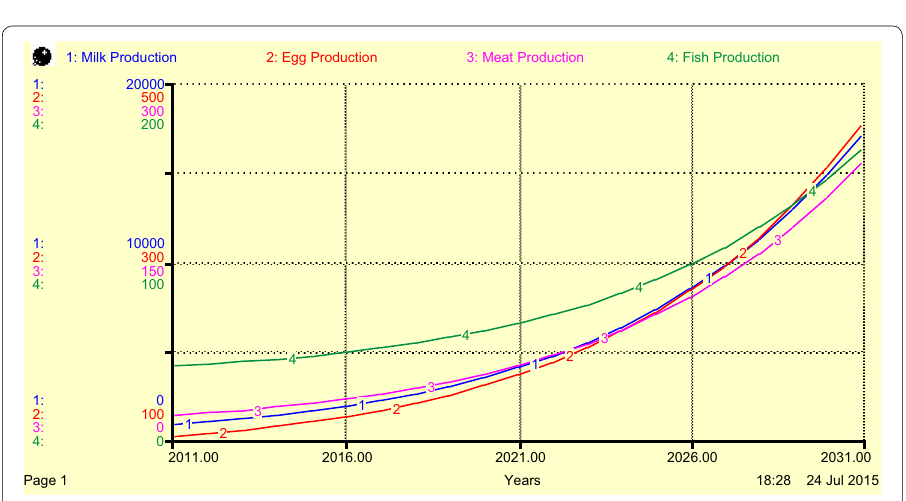
Fig. 20 Perceived projected production of milk, egg, meat, and